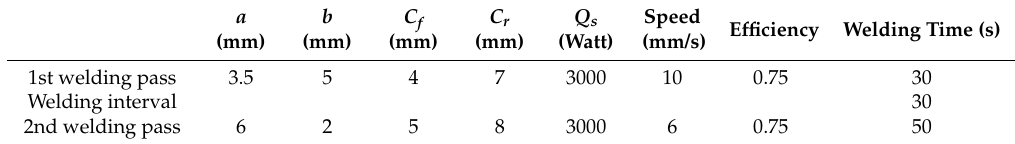
Table 2. Simulation parameters of the welding heat source.